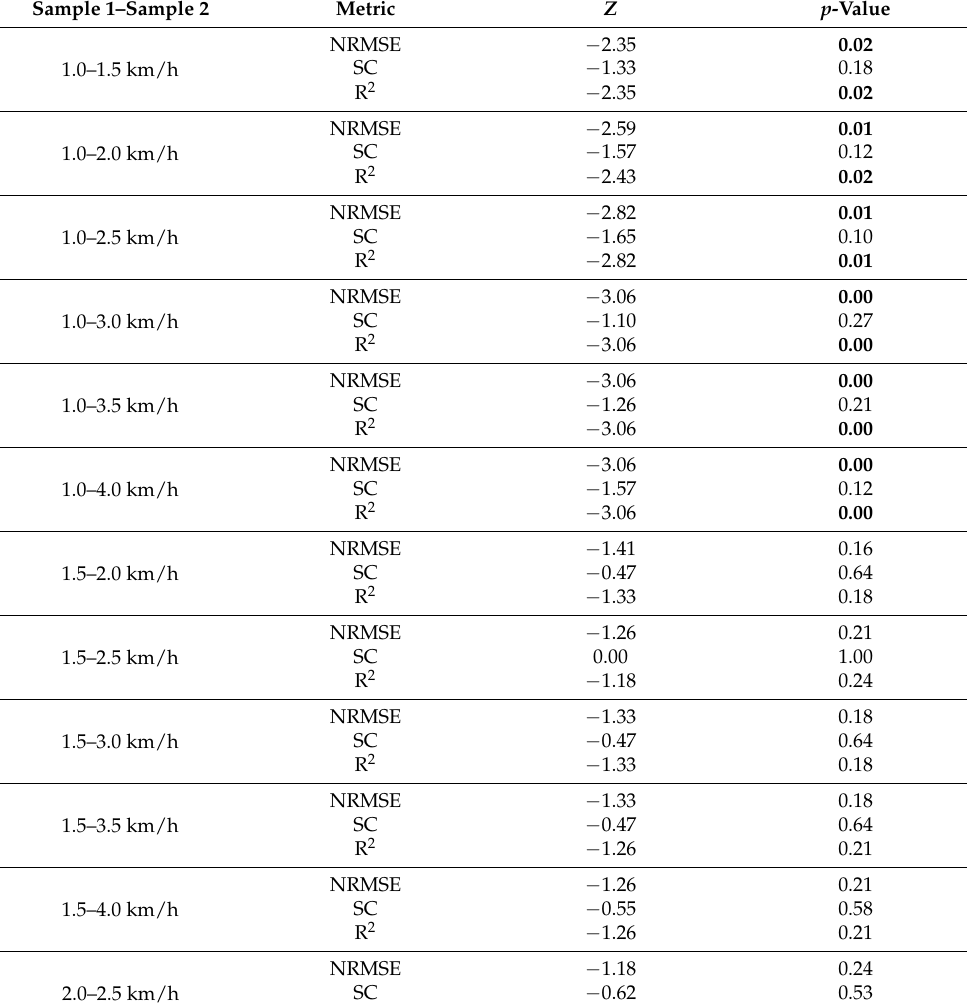
Table A1. The p -value of the related samples test for NRMSE, SC, and R 2 variables, considering the different walking speeds and a significance level of 5%. The most representative results appear in bold ( p -value <